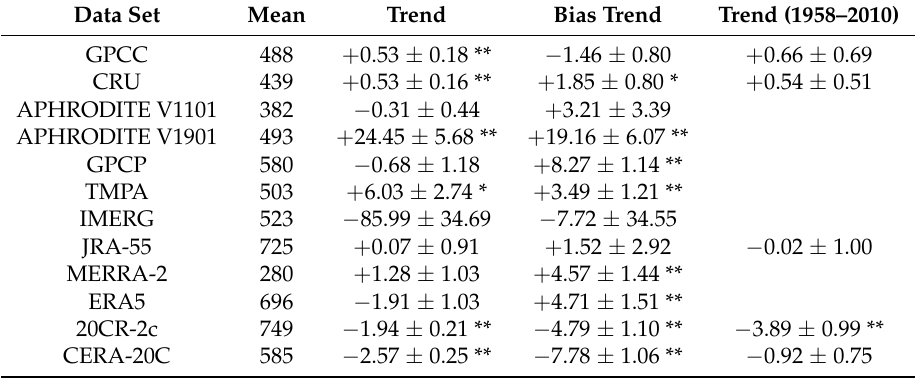
Table 3. Mean and linear trend for the precipitation data sets over the Indus basin. Units are mm y − 1 for mean precipitation and mm y − 2 for trends. Trend standard errors are given. * indicates that